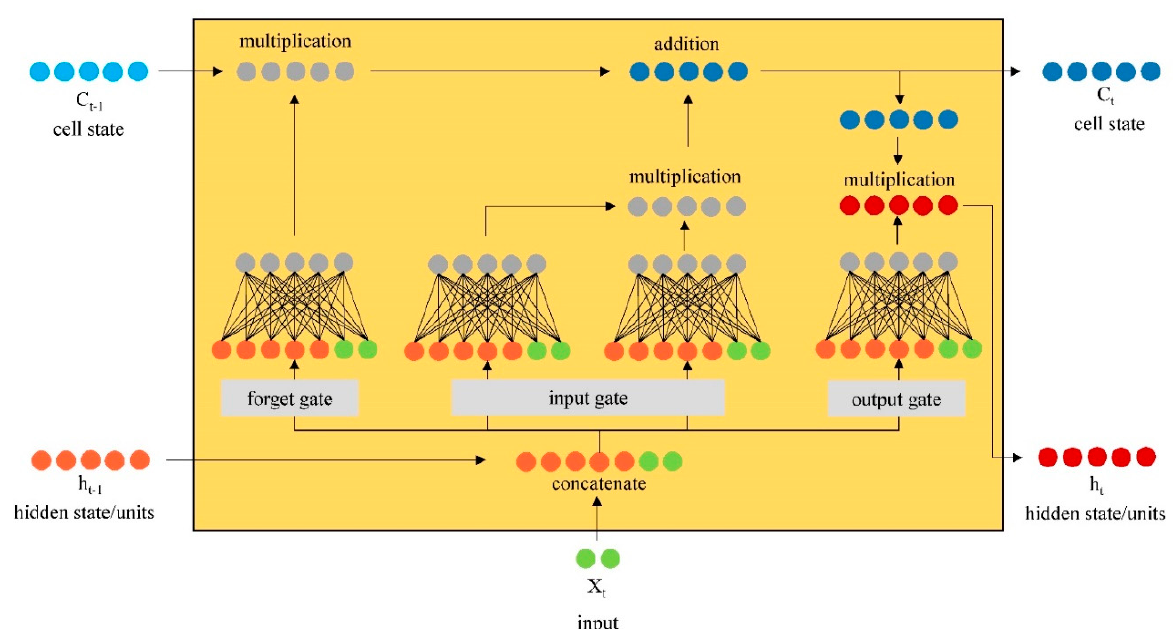
Figure 6. Internal structure of LSTM unit, with five hidden units and an input dimension of 2 [86].